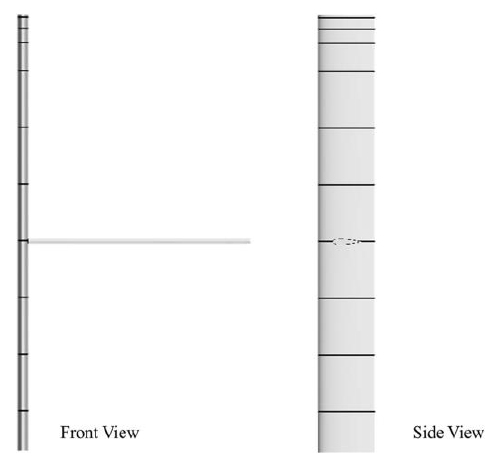
Figure 19. Blade-supporting strut rotor model.